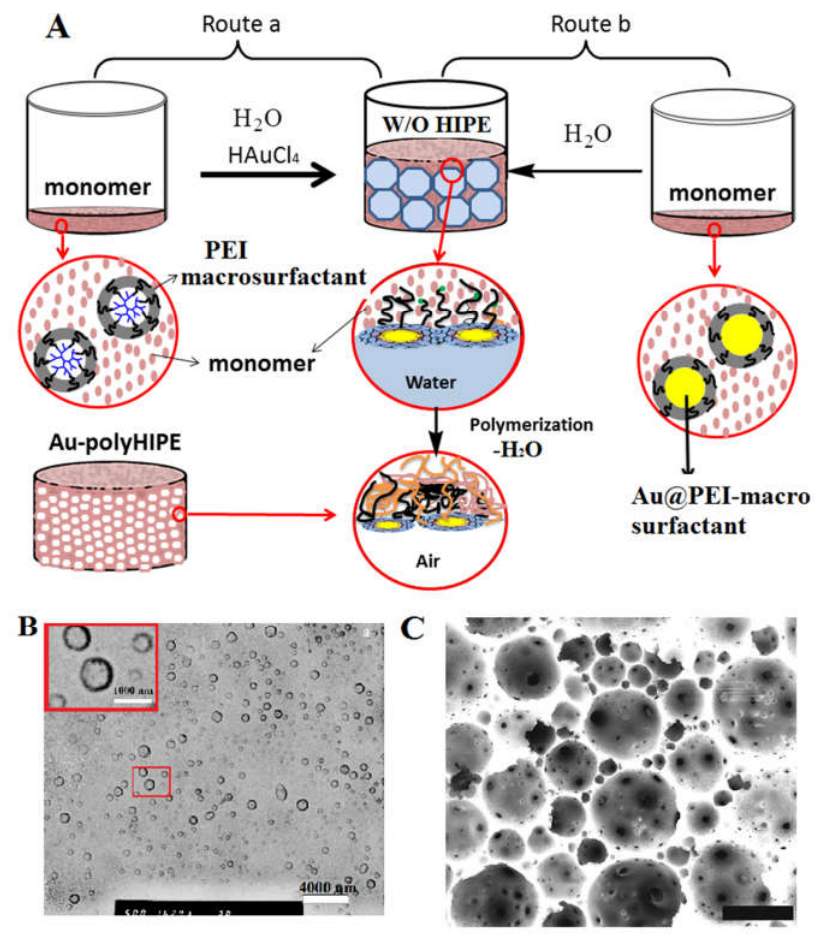
Figure 6. ( A ) Schematic of two routes for PEI macrosurfactant-mediated synthesis of gold nanoparticle-dictated polyHIPE: (a) chloroauric-containing water is dispersed in PEI-macrosurfactant-containing monomer and (b) water is dispersed in Au@PEI-macrosurfactant (gold nanocomposite)-containing monomer; ( B ) TEM micrograph of Au@PEI-macrosurfactant stabilized emulsion; and (C) SEM micrograph of polyHIPE with the surface dictated by gold nanoparticles [5]. The scale bar is 4000 nm (1000 nm inset) for ( B ) and 20  m for ( C ).